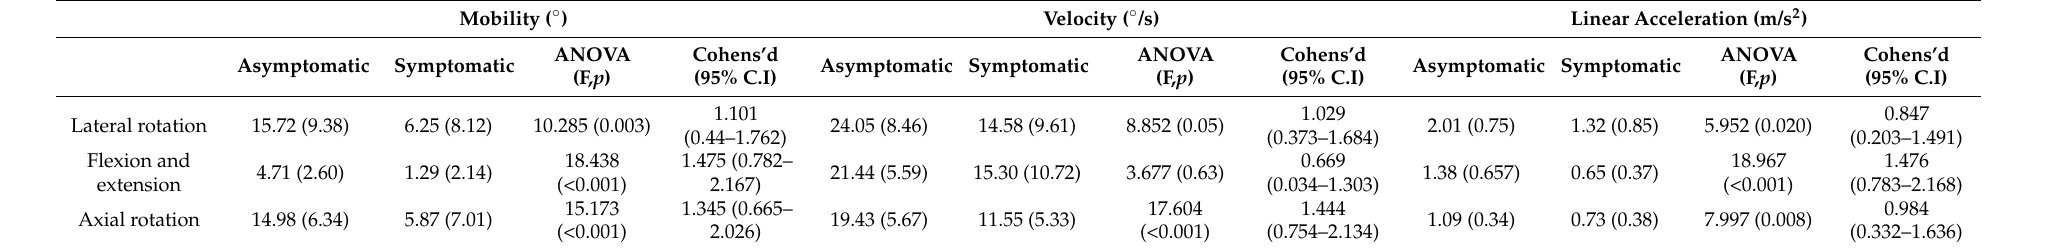
Table 4. Sternum kinematics variables mean (SD) in Asymptomatic subjects and Symptomatic and difference between groups.